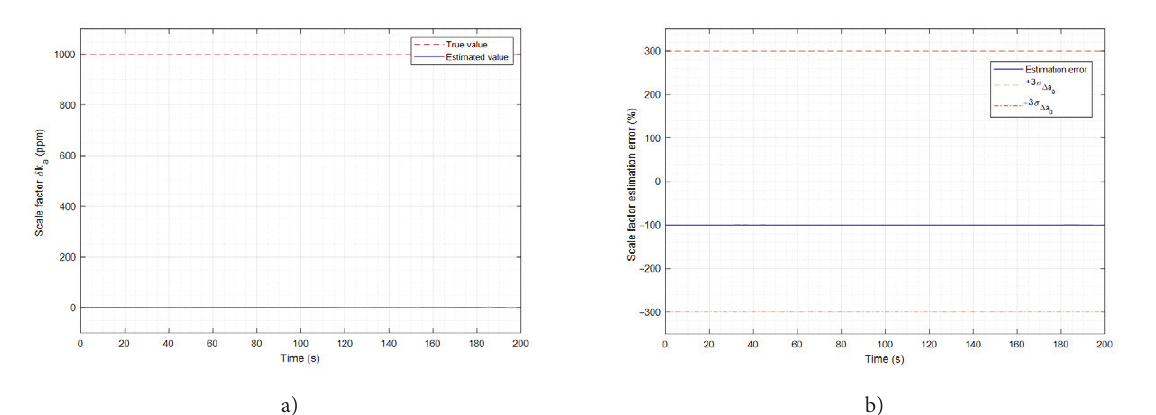
Figure 6. Scale factor estimation during stabilized level fl ight: a – estimated value; b – estimation error